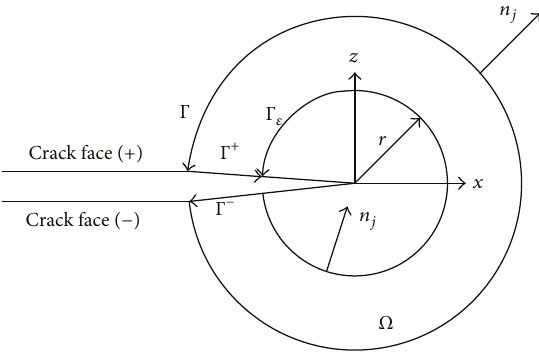
Figure 5: Combined integration path around a crack